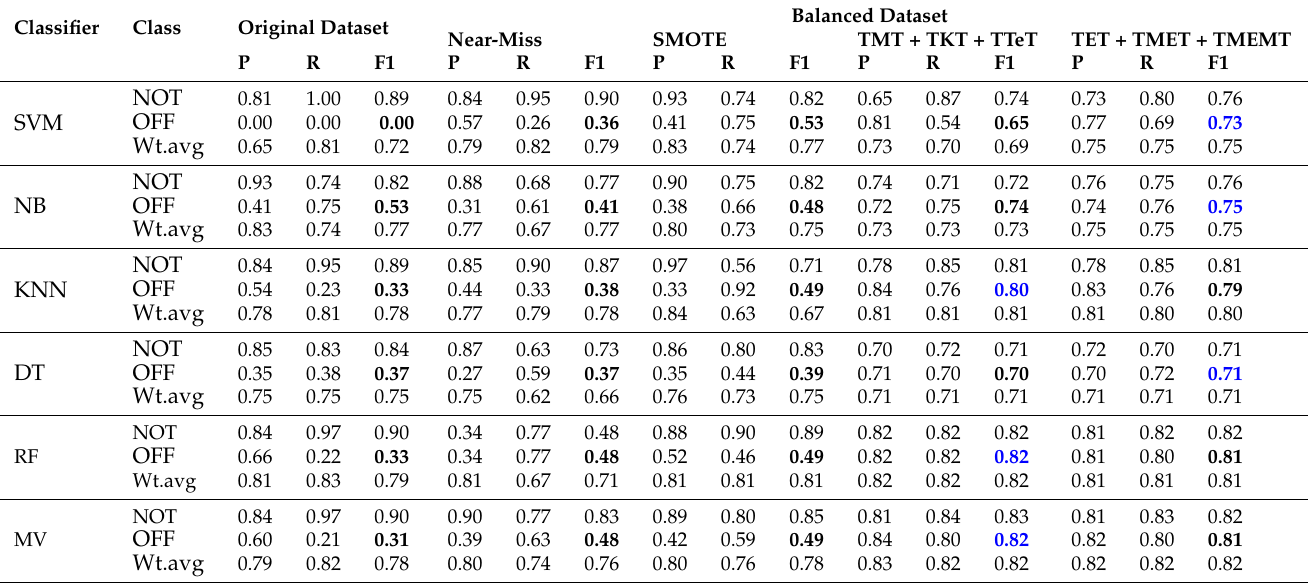
Table 3. Performance analysis of existing undersampling, oversampling and proposed